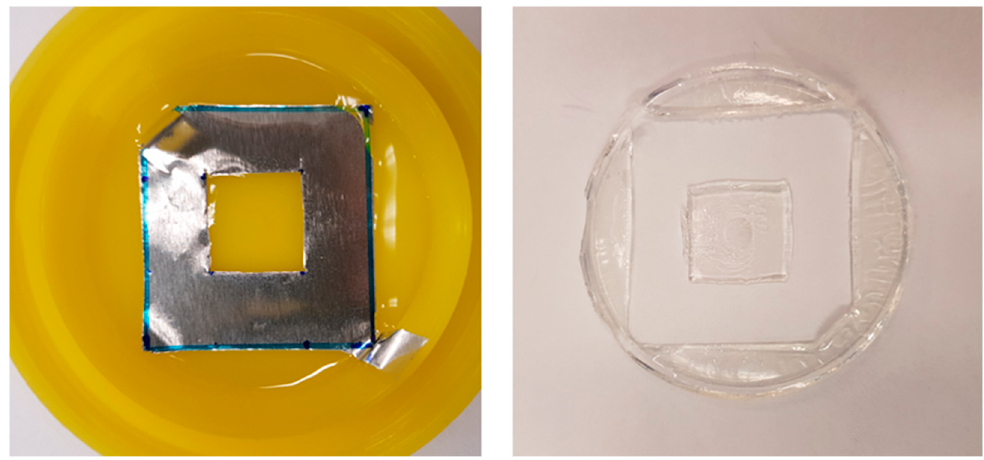
Figure 10. Simple photomask and the resulting part made by two-step polymerisation (50/50 + 5% GMA).